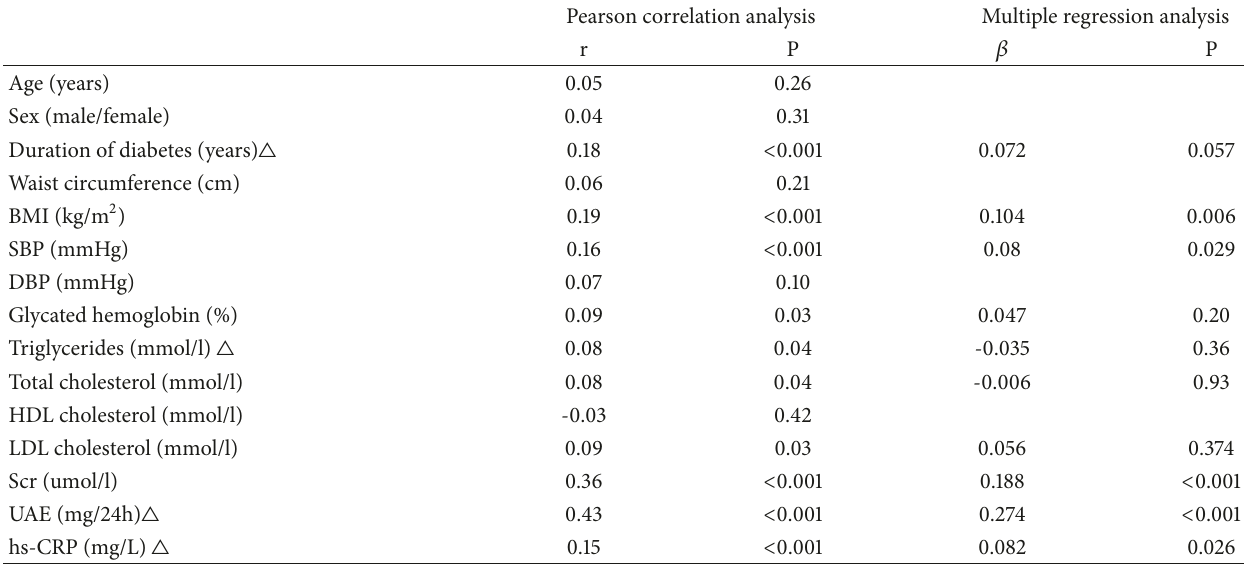
Table 3: The correlation of plasma chemerin levels with other parameters.